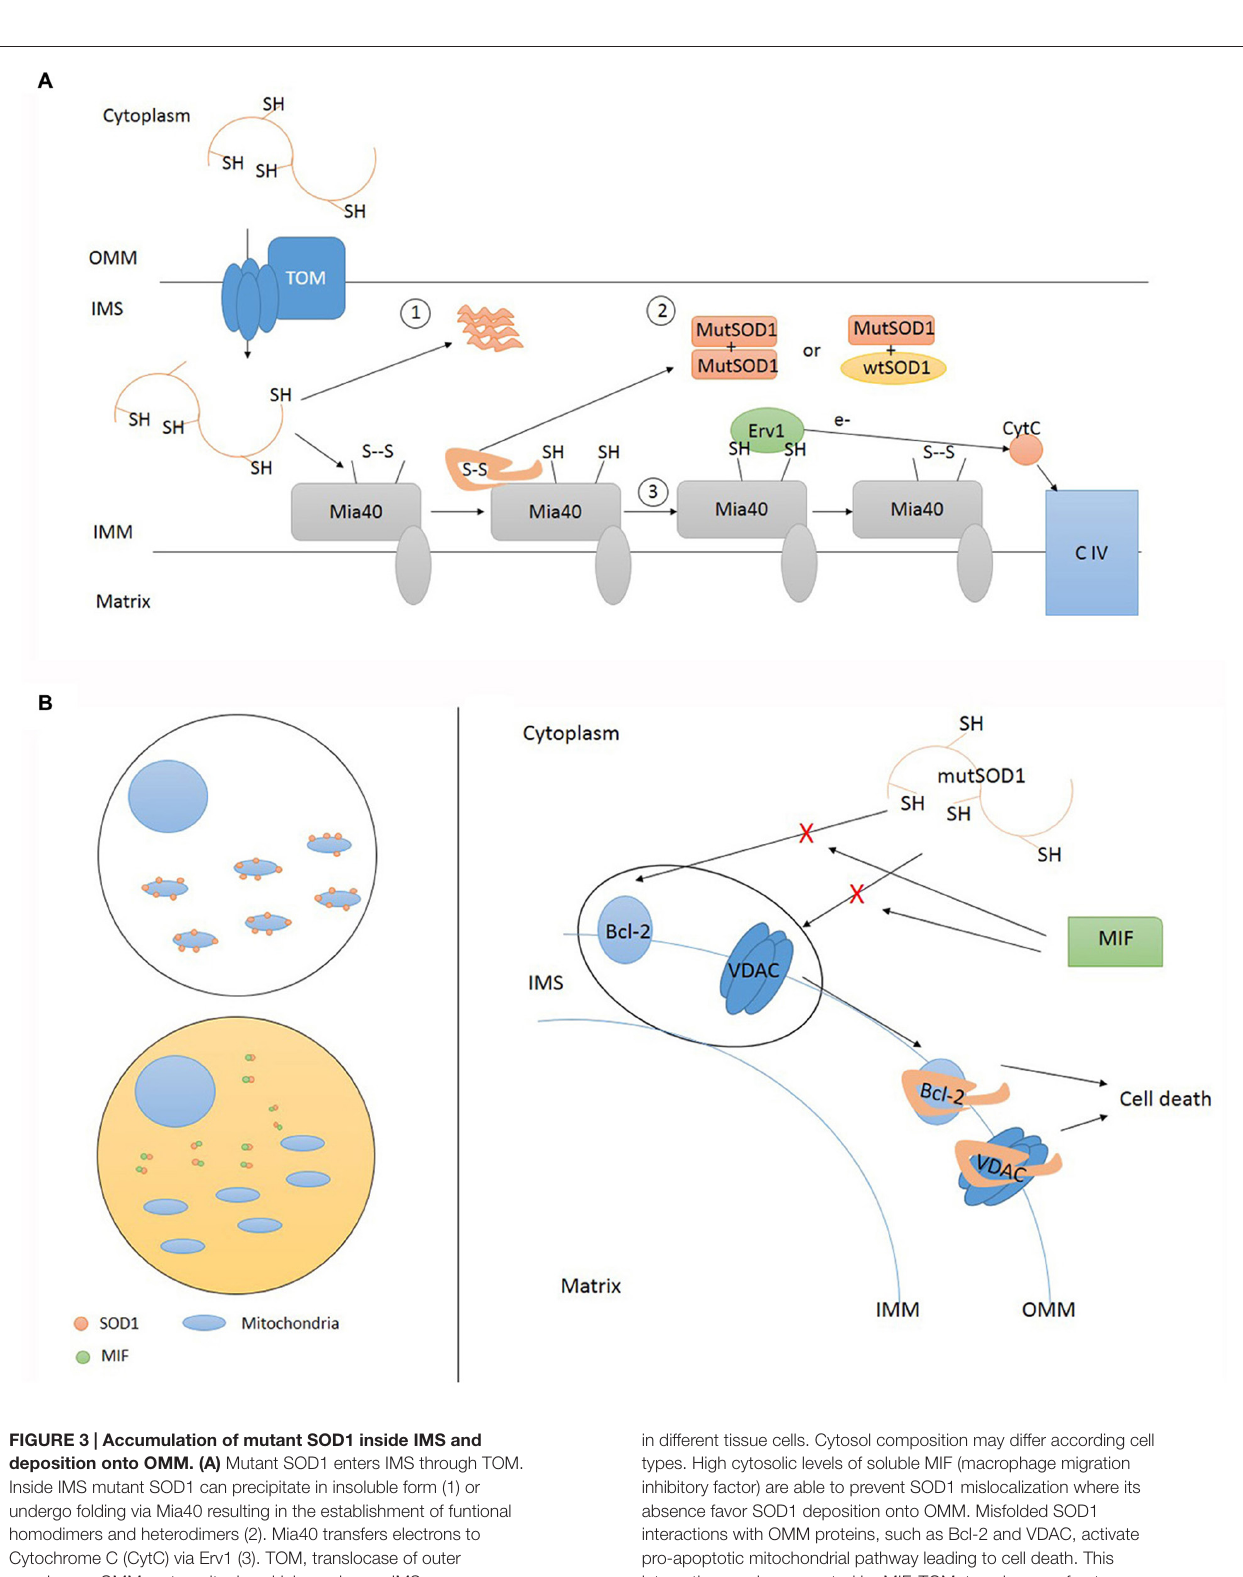
in different tissue cells. Cytosol composition may differ according cell types. High cytosolic levels of soluble MIF (macrophage migration inhibitory factor) are able to prevent SOD1 mislocalization where its absence favor SOD1 deposition onto OMM. Misfolded SOD1 interactions with OMM proteins, such as Bcl-2 and VDAC, activate pro-apoptotic mitochondrial pathway leading to cell death. This interaction can be prevented by MIF. TOM, translocase of outer membrane; OMM, outer mitochondrial membrane; IMS, intermembrane space; IMM, inner mitochondrial membrane; CIV, complex IV cytochrome C oxidase; MutSOD1, mutant